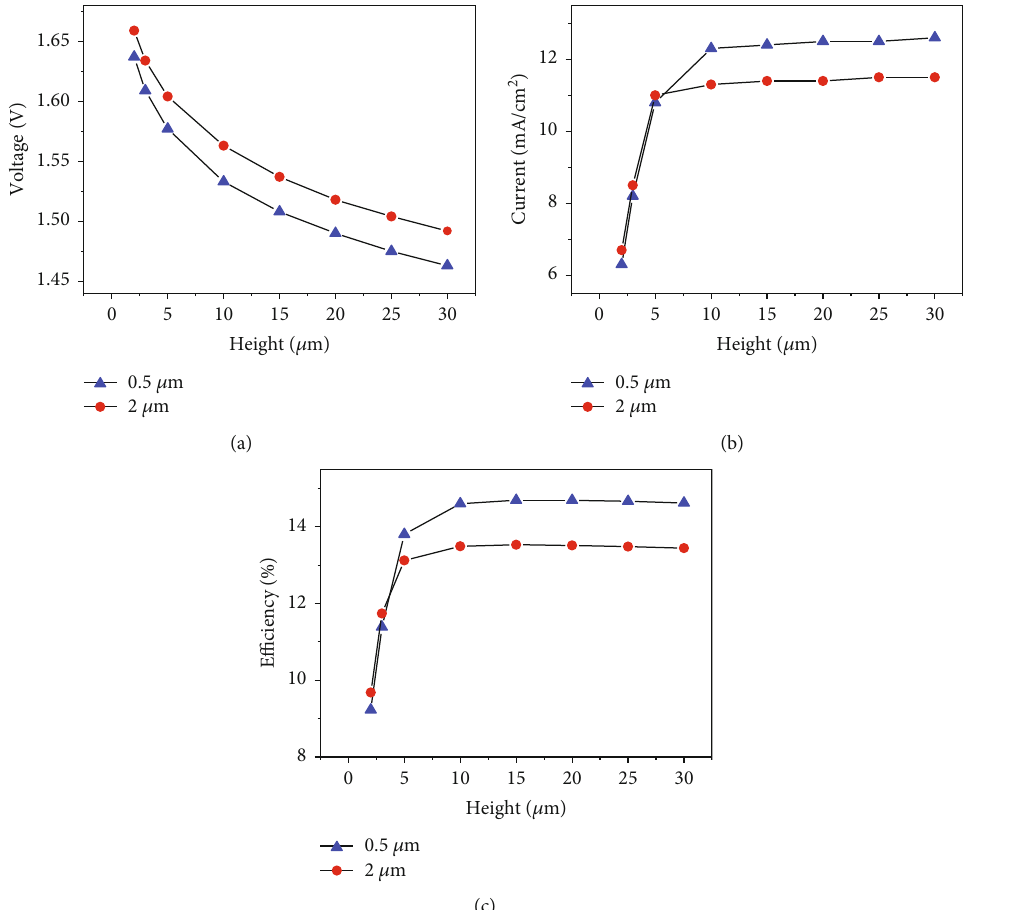
ffi ciency on the height of the Si wire for the MCC lifetime of 1 ms and the wire Figure 8: Dependences of (a) V OC , (b) J SC , and the (c) e diameter of 0.5 μ m and 2 μ